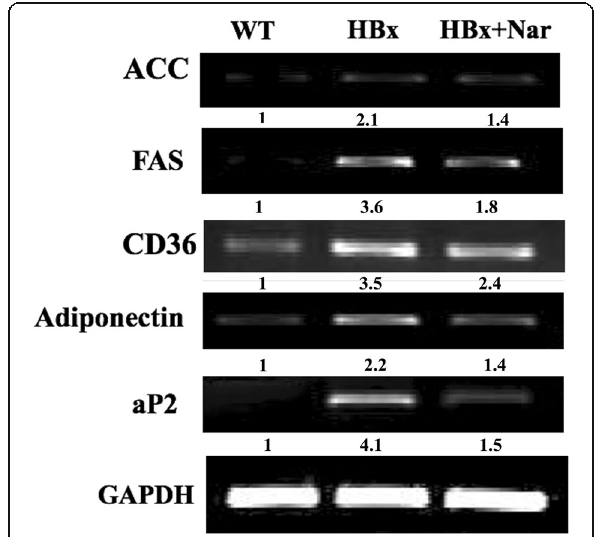
Fig. 2 The effect of naringenin on the expression of adipogenic and lipogenic genes in 8-week-old HBx-transgenic mice. RT-PCR data are representative of 5 independent